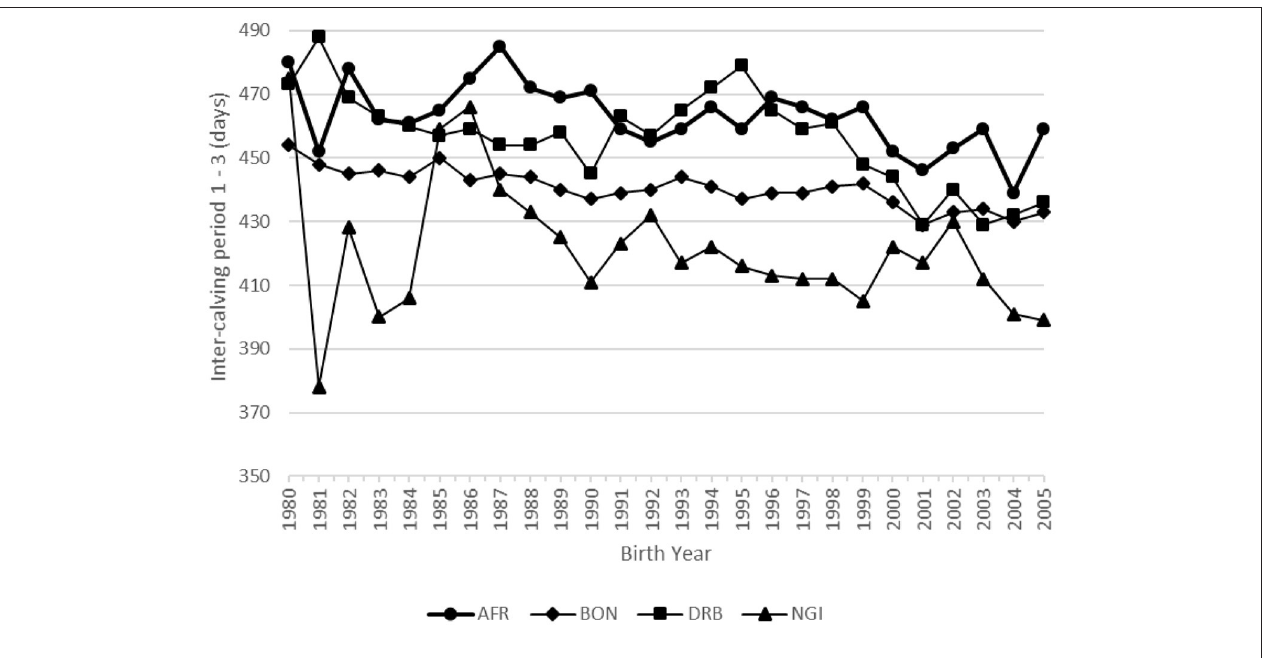
FIGURE 8 | Phenotypic trend for inter-calving period in days.